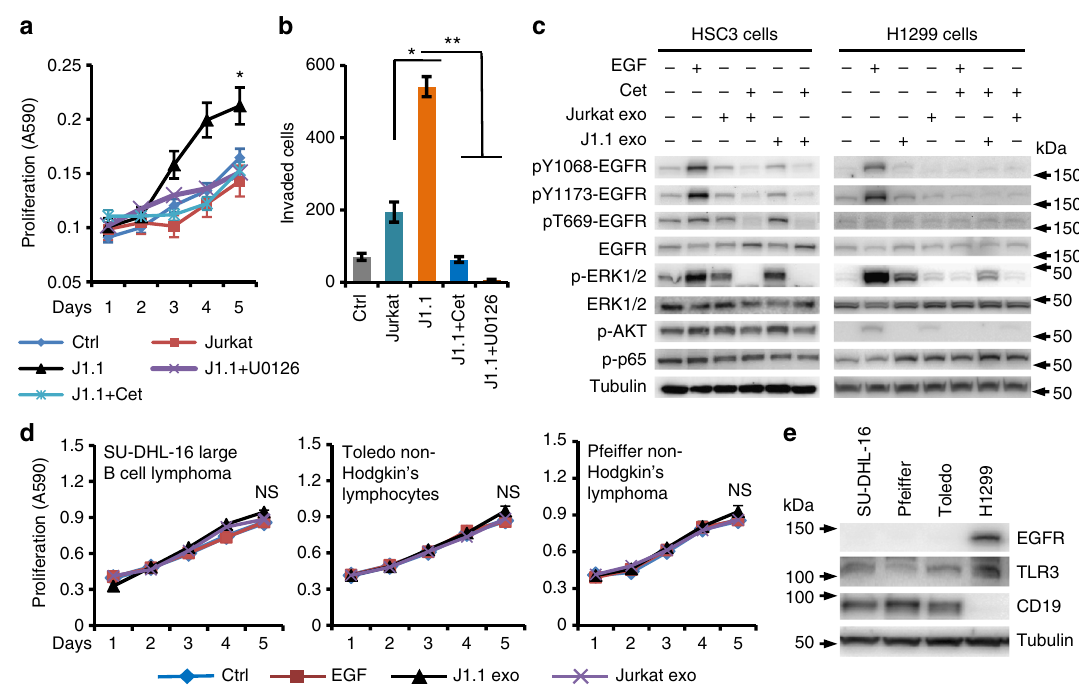
Fig. 5 J1.1 cell exosomes stimulate ERK1/2 phosphorylation via EGFR. a HSC3 cells were treated with U0126 (5 µ M, + U0126) or cetuximab (20 µ g ml − 1 , + Cet) for 30 min or remained untreated, followed by stimulation with exosomes (4 × 10 9 ml − 1 ) from J1.1 or Jurkat cells for cell proliferation. Ctrl, serum- free medium; J1.1 and Jurkat, exosomes from J1.1 and Jurkat cells, respectively. Error bars, ± s.d., n = 4, * p < 0.05, one-way ANOVA on days 3 to 5. b HSC3 cell invasion in response to exosomes (4.2 × 10 9 ml − 1 ) from Jurkat or J1.1 cells in the absence or presence of U0126 (5 µ M, + U0126) or cetuximab (20 µ g ml − 1 , + Cet). Data (mean ± s.d., n = 3) represent one experiment out of three independent repeats; * p < 0.05 and ** p < 0.02, F -test. c HSC3 HNSCC and H1299 lung cancer cells treated with exosomes (2 × 10 9 ml − 1 ) from Jurkat or J1.1 cells in the absence or presence of cetuximab (20 µ g ml − 1 , Cet) for 10 min, followed by immunoblotting on total cell lysates. EGF (10 ng ml − 1 ), positive control; kDa, protein marker size. Uncropped blot images in Supplementary Figure 4e. d Proliferation of B-cell lymphoma cell lines SU-DHL-16, Toledo, and Pfeiffer in response to exosomes (4 × 10 9 ml − 1 ) isolated from J1.1 or Jurkat cells and EGF (10 ng ml − 1 ). Data (mean ± s.d., n = 4) represent one experiment from two independent repeats. NS, p > 0.05, one-way ANOVA on days 3 to 5. e Immunoblot of total EGFR (EGFR), TLR3, and CD19 using total cell lysates from SU-DHL-16, Pfeiffer, Toledo, and H1299